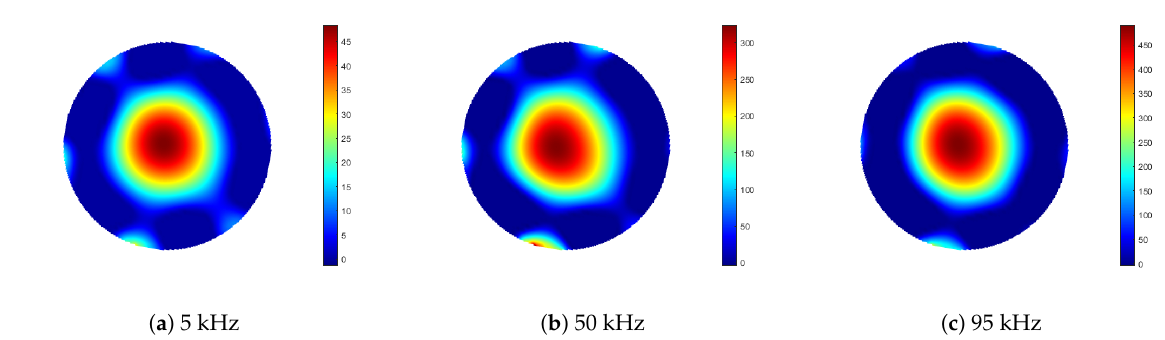
Figure 11. Photographs of internal object measurements using an aluminium rod and copper shroud.